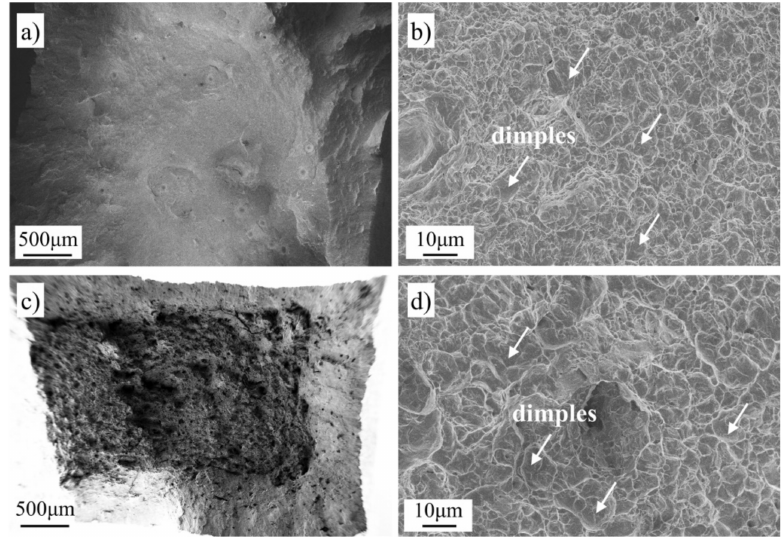
Figure 7. Scanning electron microscopy (SEM) characterization of the tensile fracture surface, ( a ) and ( b ) tensile fracture surface of the as-built sample, ( c ) and ( d ) tensile fracture surface of the HIPed